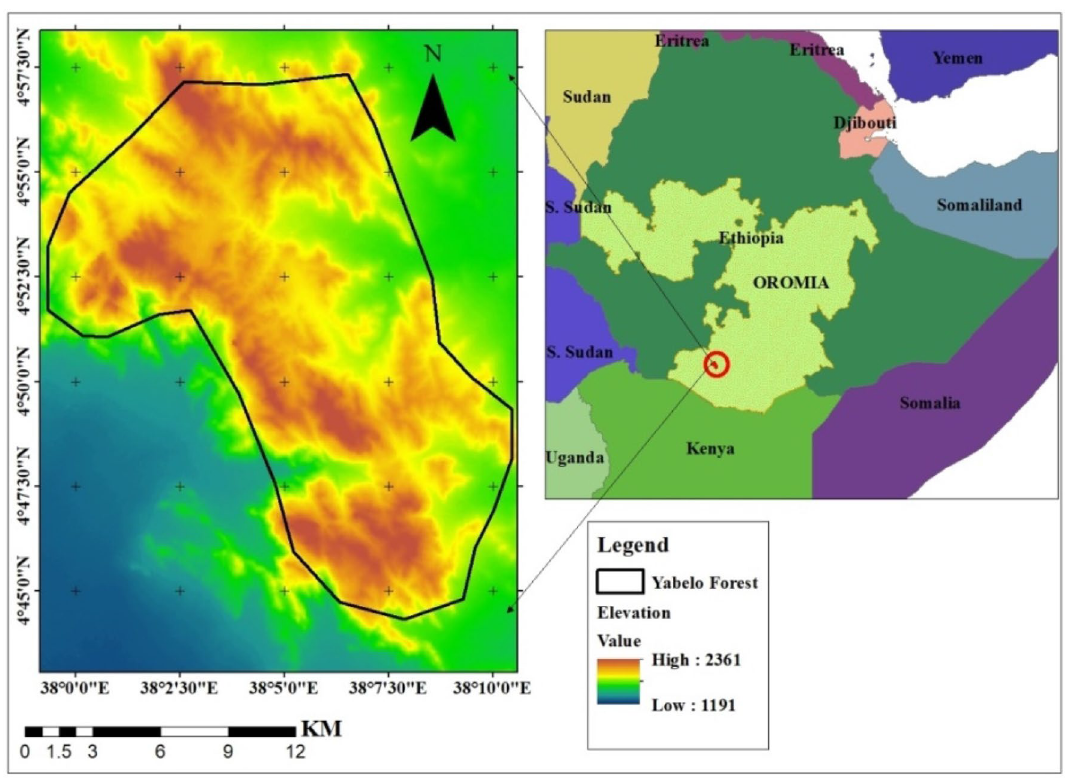
Fig. 1 Map of Yabelo forest